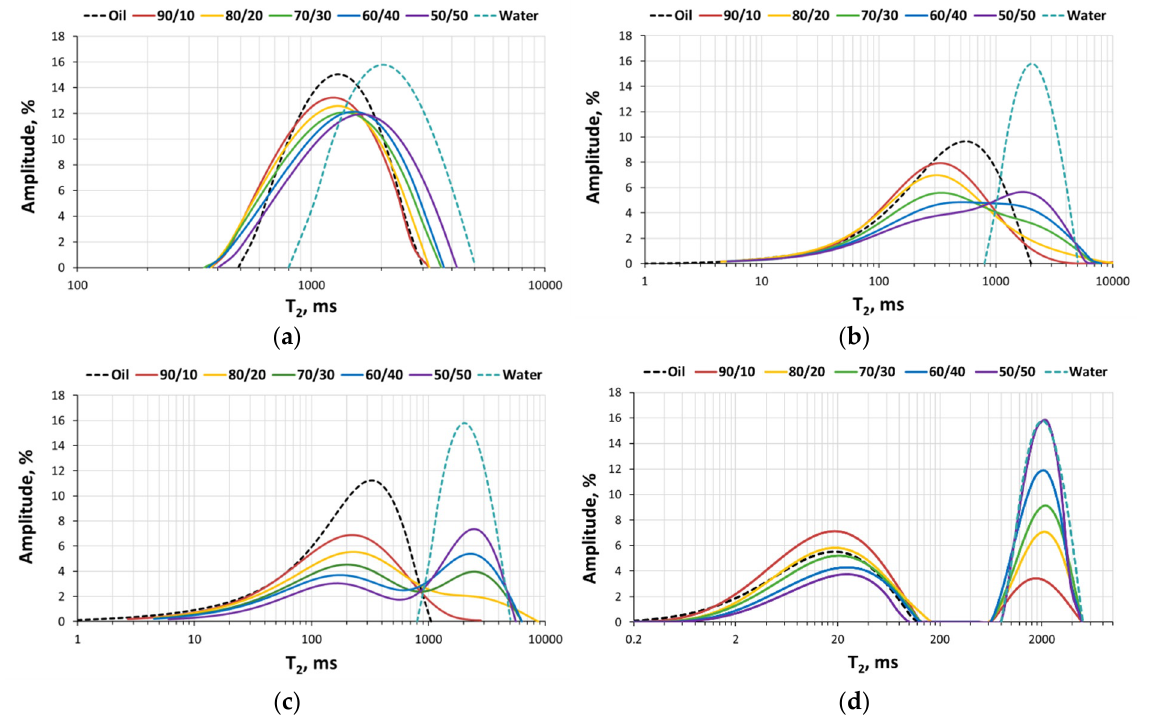
Figure 1. Transverse relaxation time spectra for the water–oil mixtures: ( a ) A1–A5; ( b ) C1–C5; ( c ) D1–D5, ( d ) E1–E5. ( c ) D1–D5, ( d )